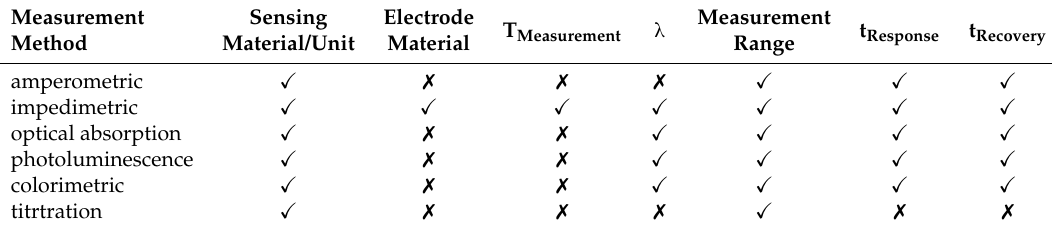
Table 2. Overview of the key parameters for amperometric, impedimetric, optical absorption, photoluminescence, colorimetric, and titration-based measurement